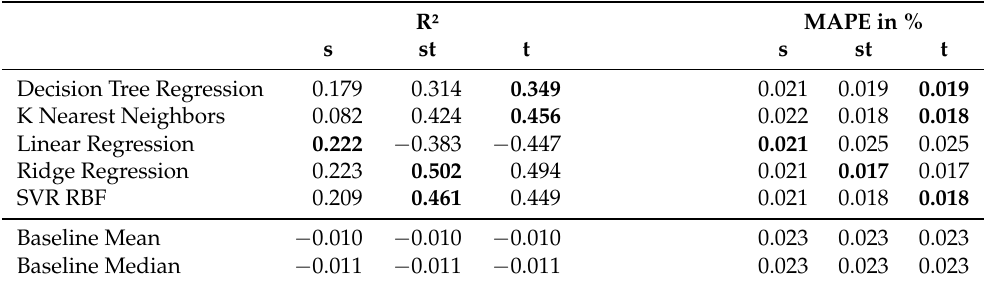
Table 5. Data Set Housing Part II: Results for Target Distance A. The highest R 2 and the lowest MAPE are shown in bold for each algorithm. The differences in comparisons of st or t vs. s are all significant according to the Wilcoxon signed-rank test ( α =